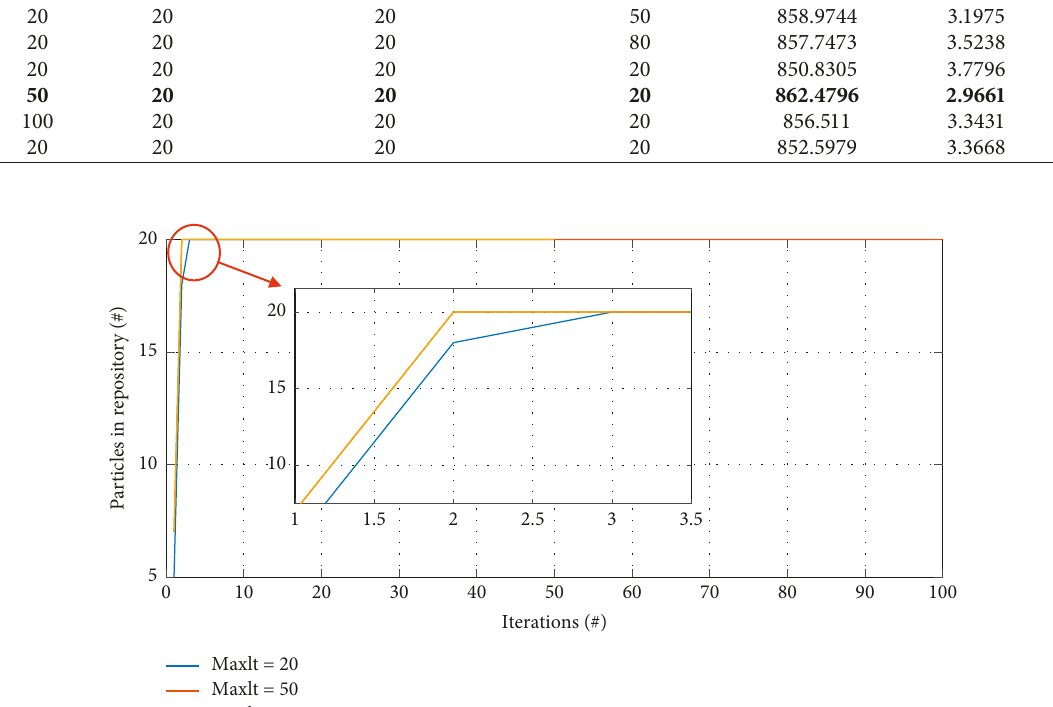
Figure 5: Convergence characteristics at different iterations.